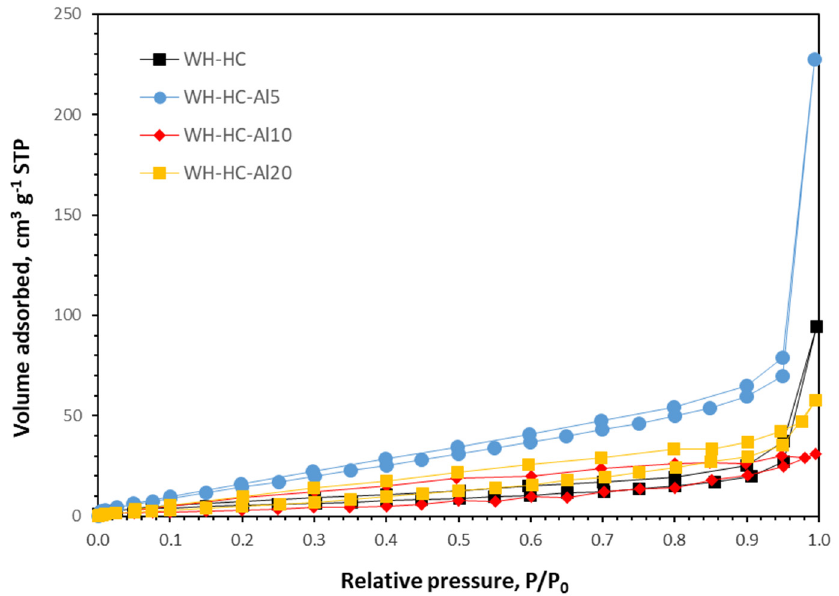
Figure 2. N 2 adsorption/desorption isotherms at − 196 °C of uncatalyzed HC and HCs prepared by Al-catalyzed HCs.